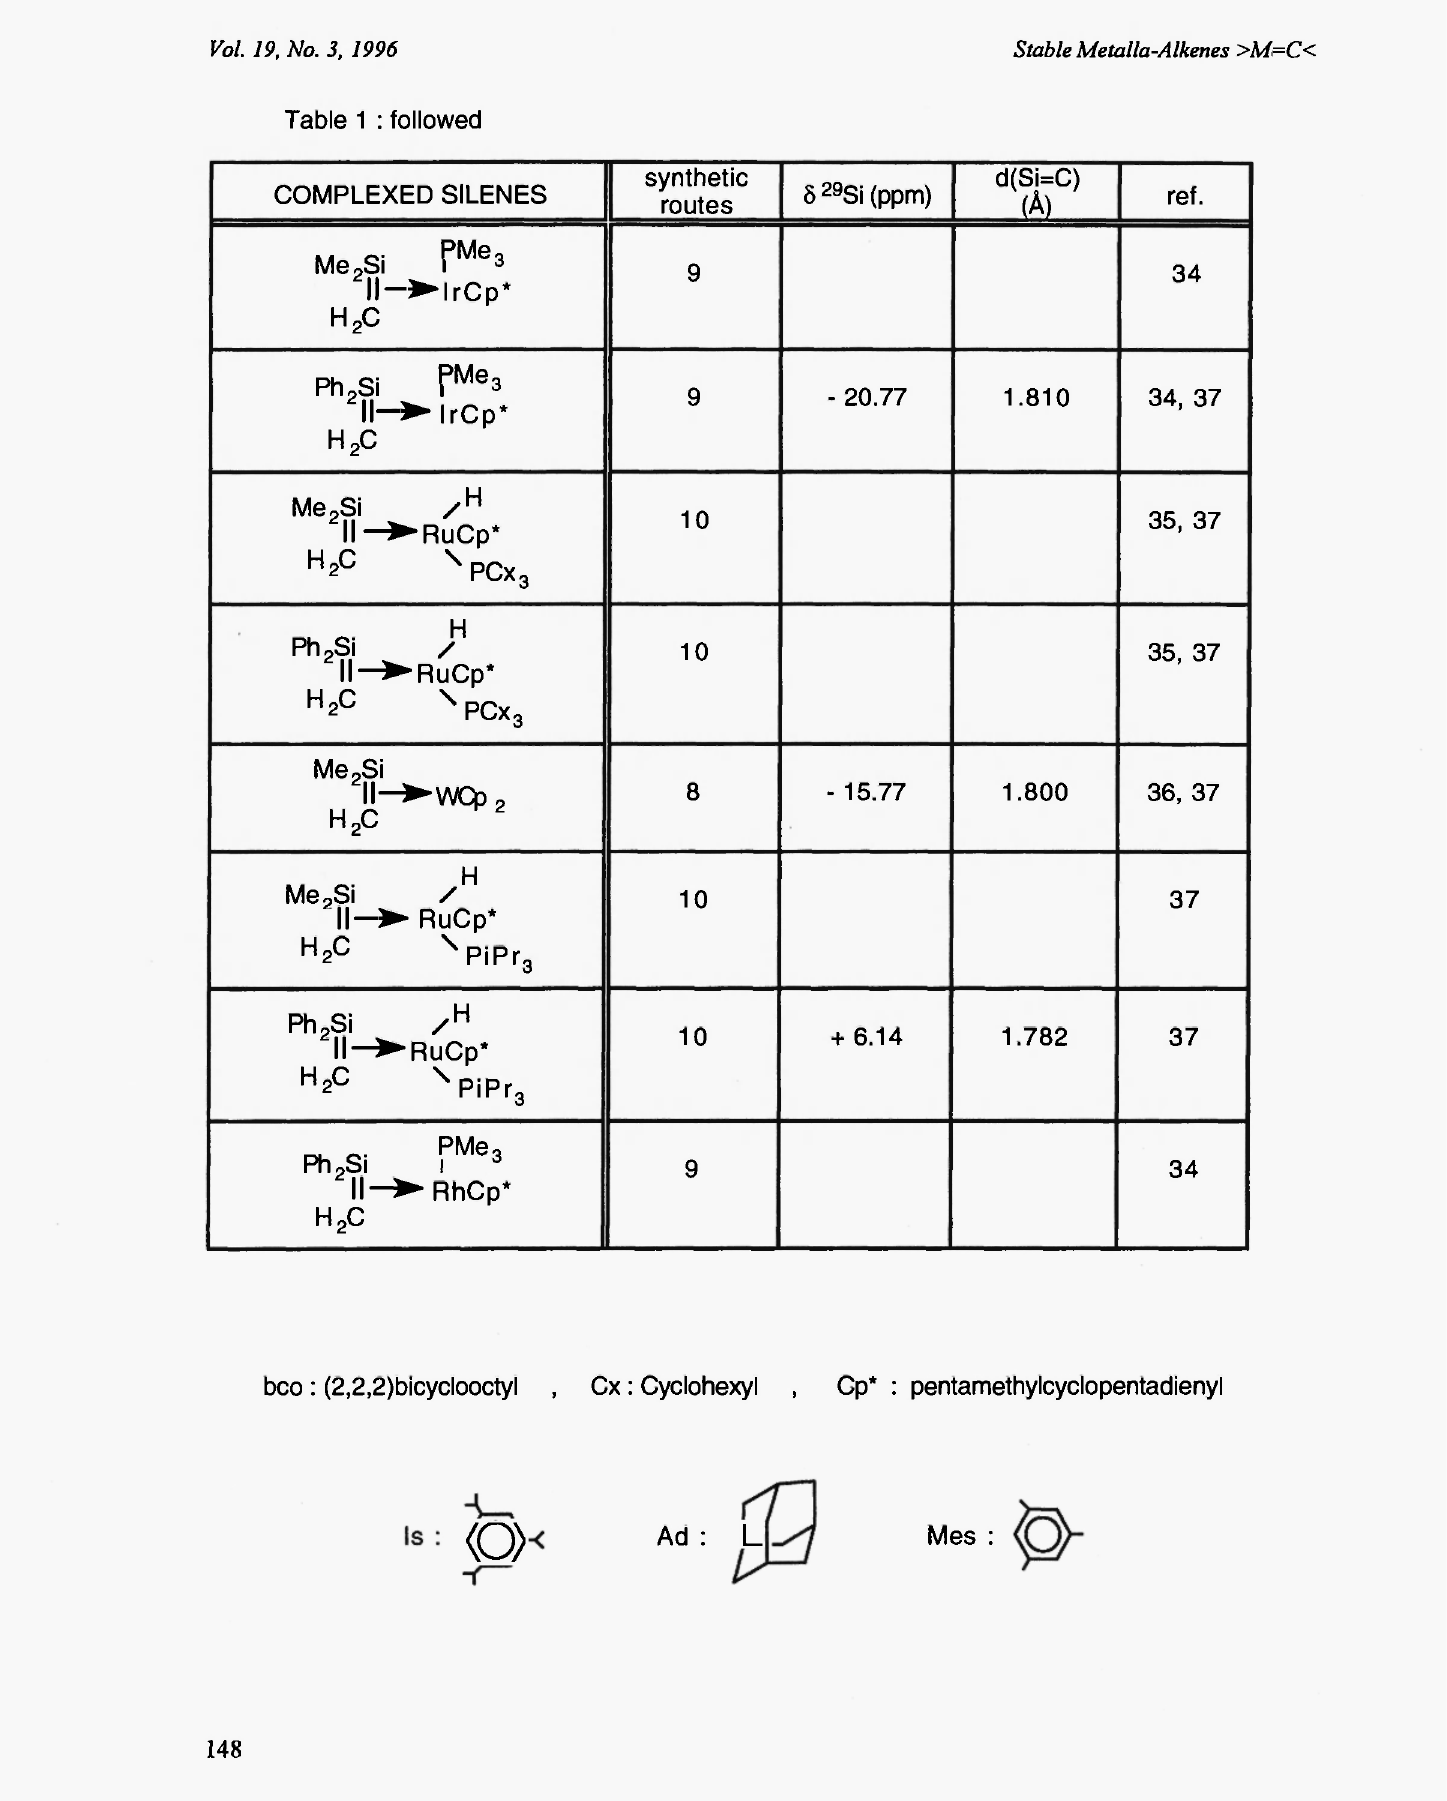
COMPLEXED SILENES